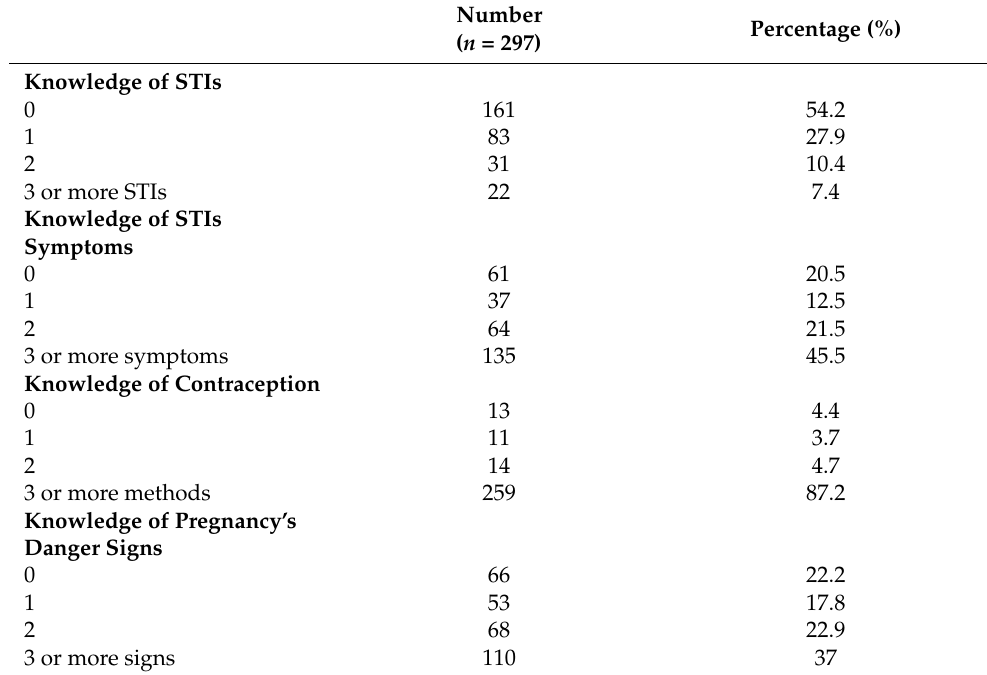
Table 3. Sexual and Reproductive Health Knowledge of